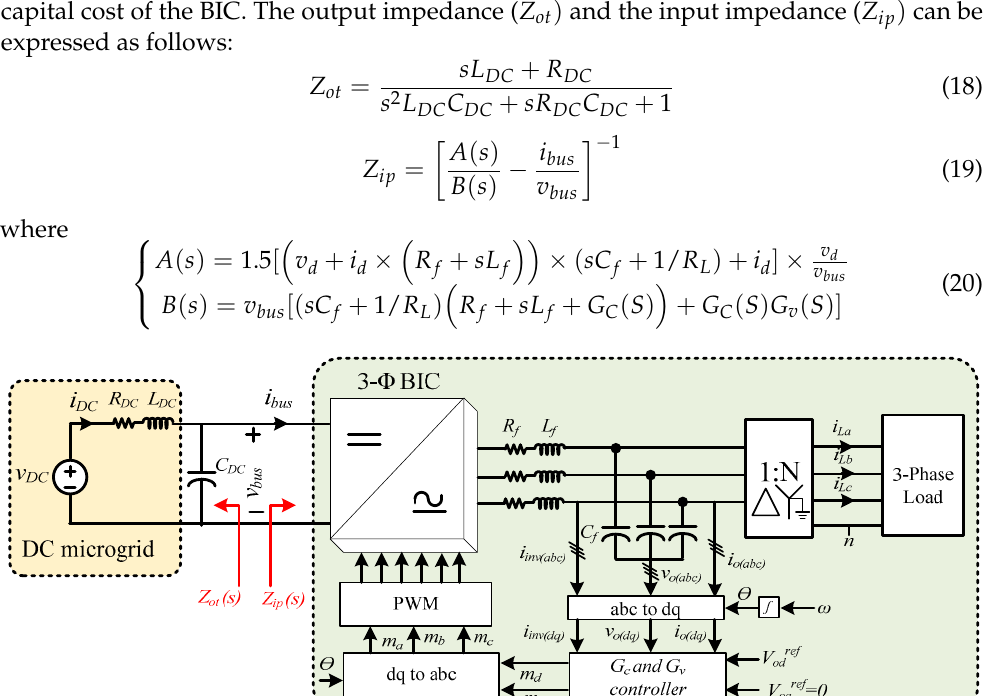
Figure 14. Cascaded system given in [93].